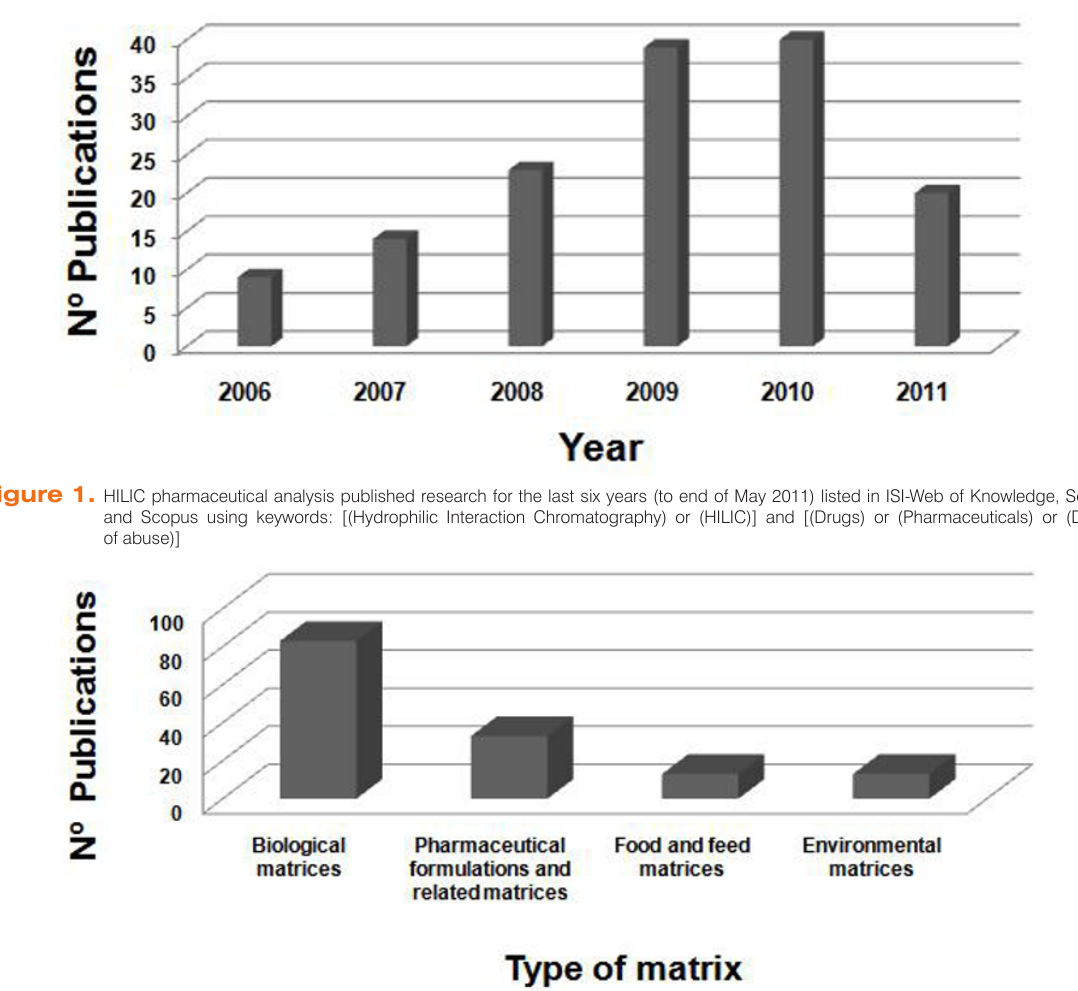
Figure 2. Sample matrices analyzed with HILIC between 2006 and